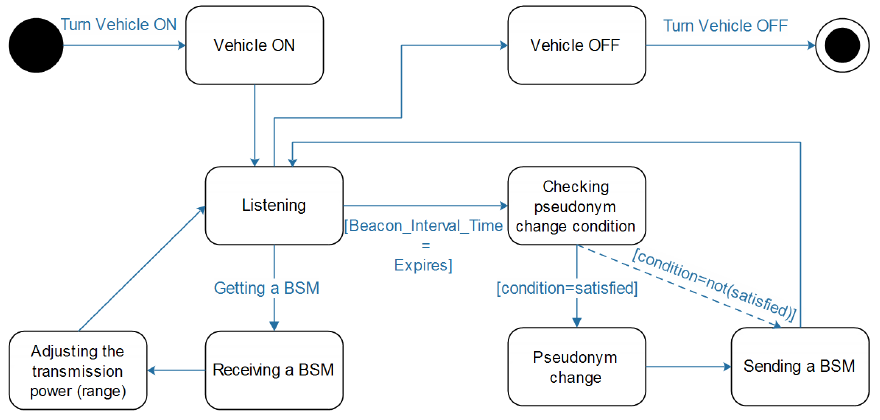
Figure 6. The state diagram of